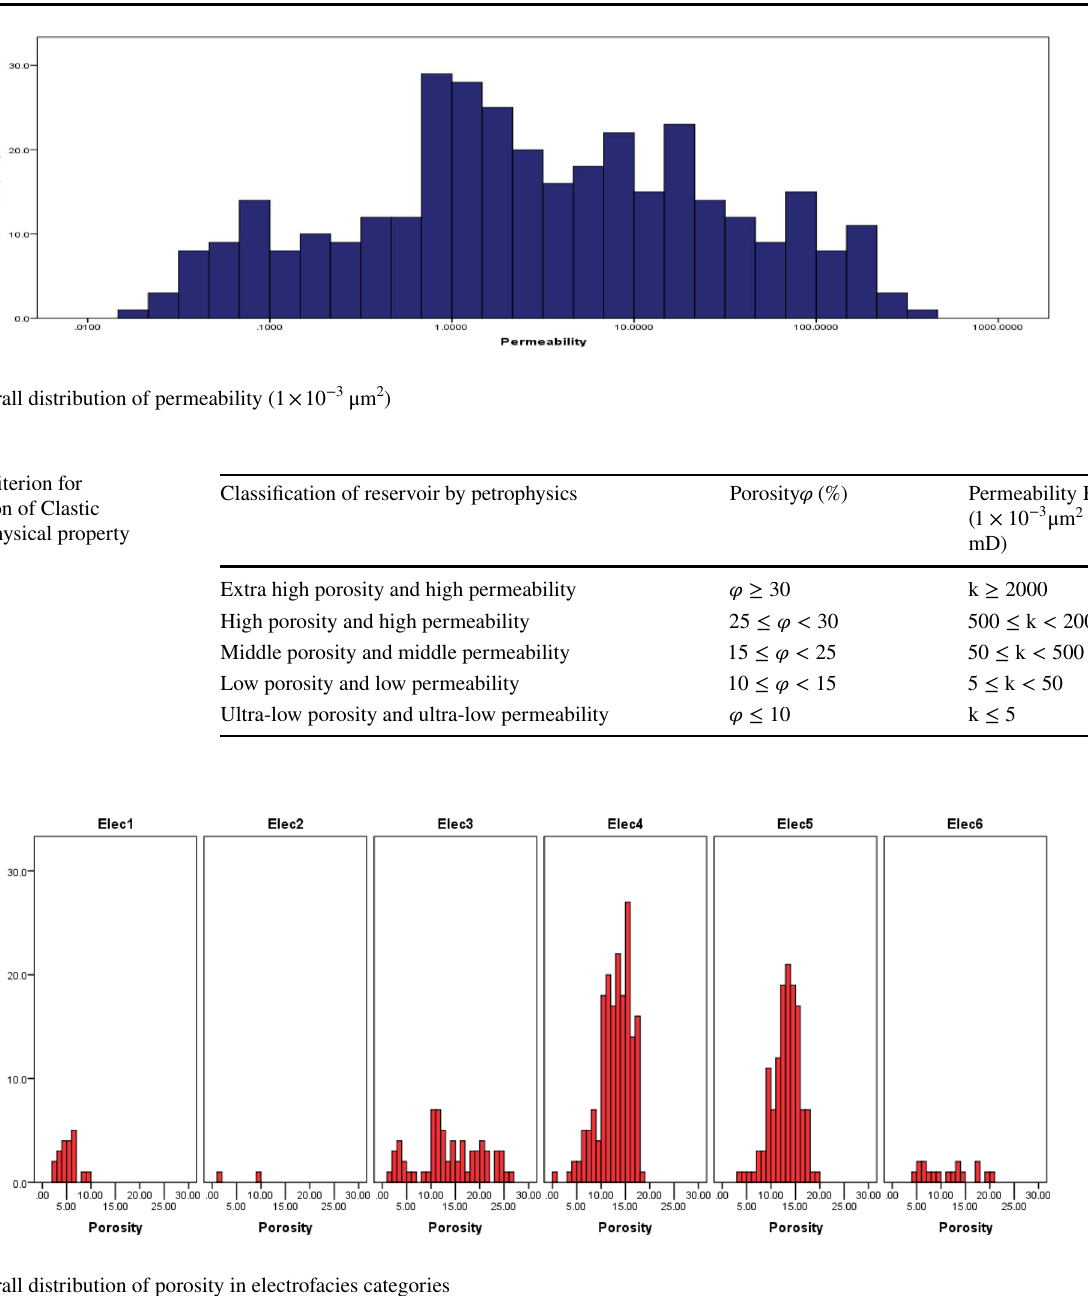
Fig. 3 Overall distribution of porosity in electrofacies